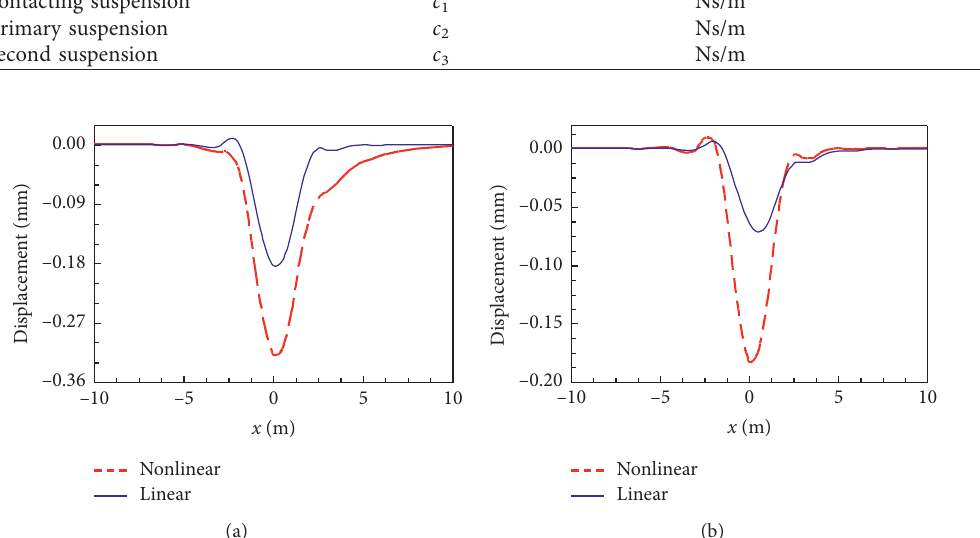
Figure 6: The history of vertical displacement at the middle of the track corresponding with location of the moving vehicle in both the foundation model: (a) v � 25m/s and (b) v �